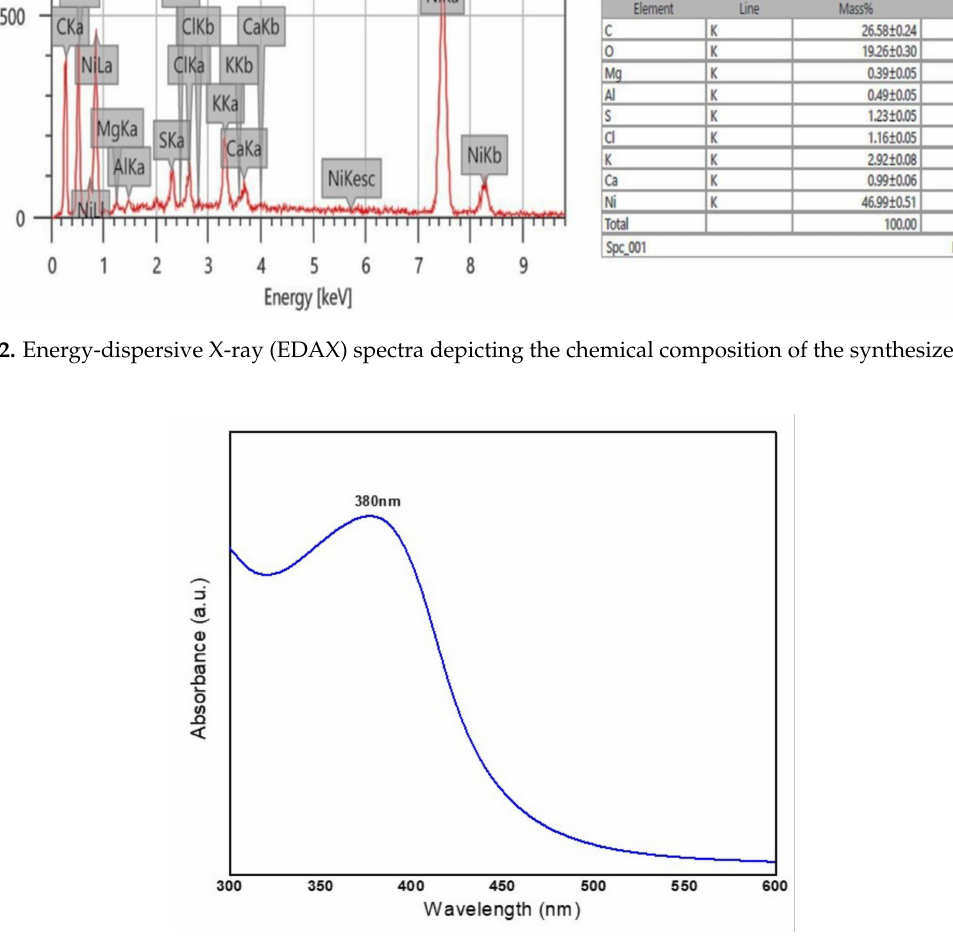
Figure 3. UV-Visible Spectrum of as-prepared NiO